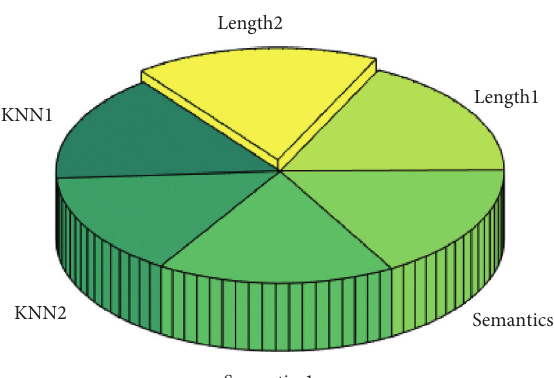
Figure 4: Search filtering experiment result 1.